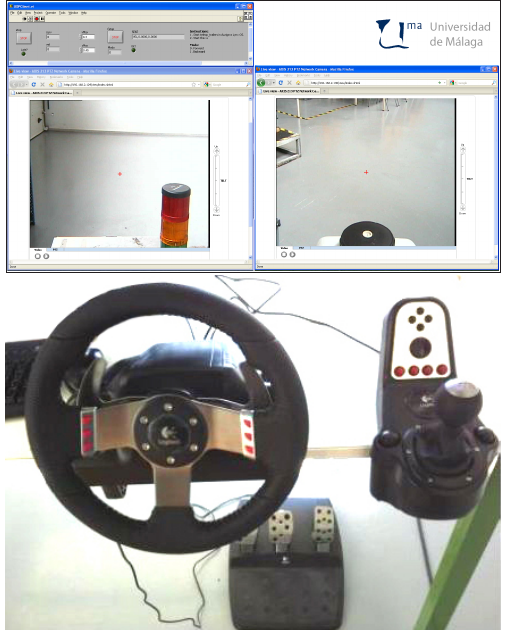
Figure 5. ADAS Driver Interface: Dashboard display screen capture ( top ), and drive-by- wire controls ( bottom